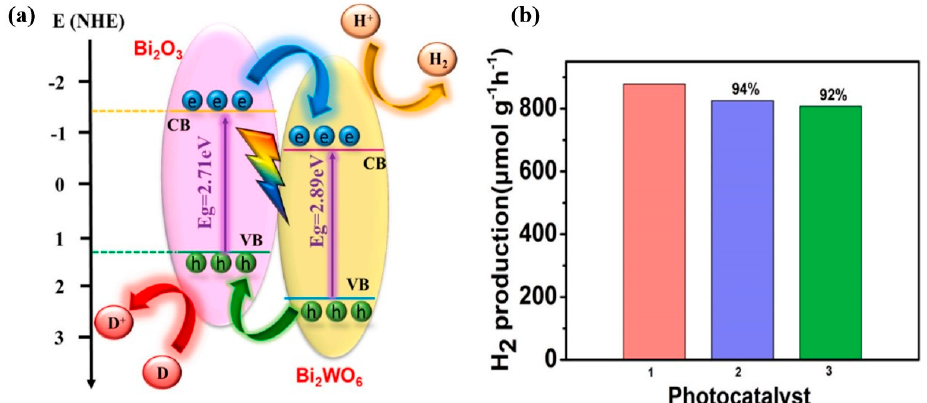
Figure 11. ( a ) Proposed band structures and photocatalysis mechanism of the Bi 2 O 3 -Bi 2 WO 6 photo- catalyst and ( b ) cycling tests of photocatalytic H 2 evolution through the BWA400 photocatalyst. [Re- printed with permission from reference [107]. Copyright 2021,